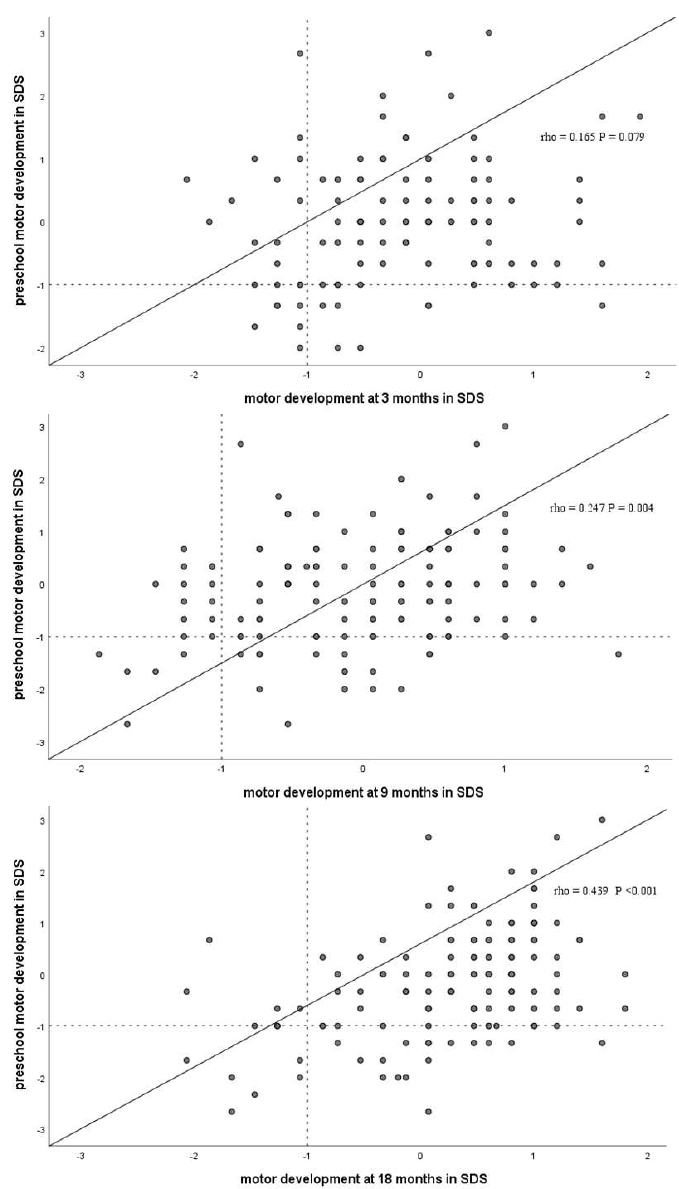
Figure 2. Individual stability between motor developmental measures. Correlations and corresponding p -values for motor function are presented for the time intervals 3–42 months, 9–42 months and 18–42 months. Children with unstable development on the different measurements (increase < − 1 SD to > − 1 SD or decrease > − 1 SD to < − 1 SD) are in the quadrants at the top left and bottom